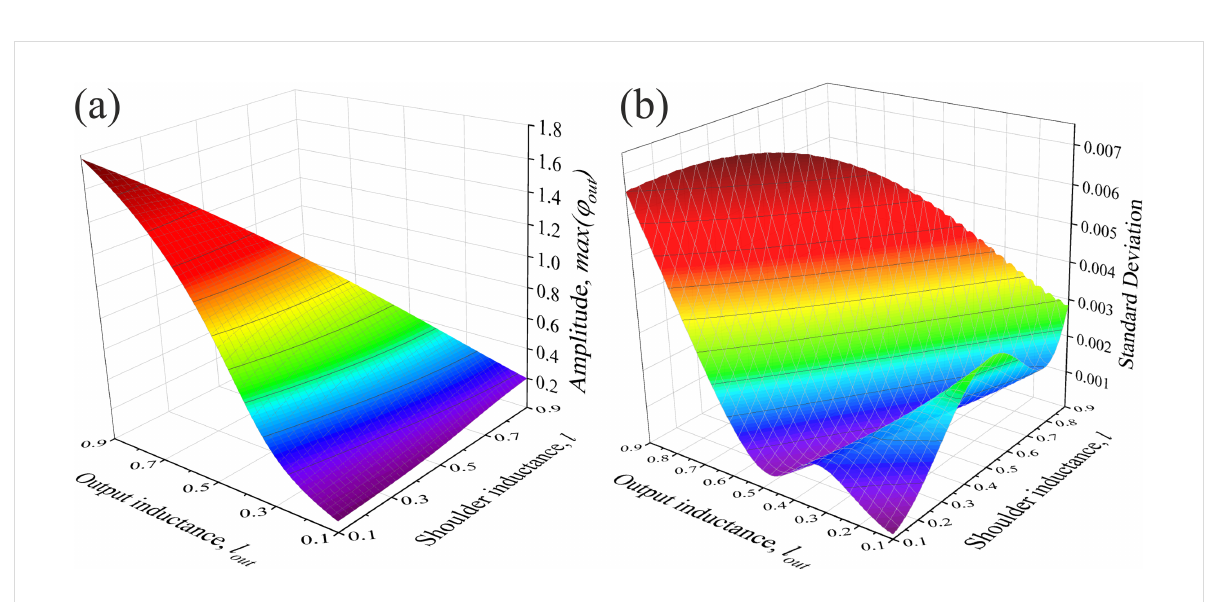
Figure 3: (a) Amplitude of the transfer function and (b) its standard deviation from the Gaussian-like function depending on the inductances l and l out of the G-cell. The bias flux is equal to 0.05 π